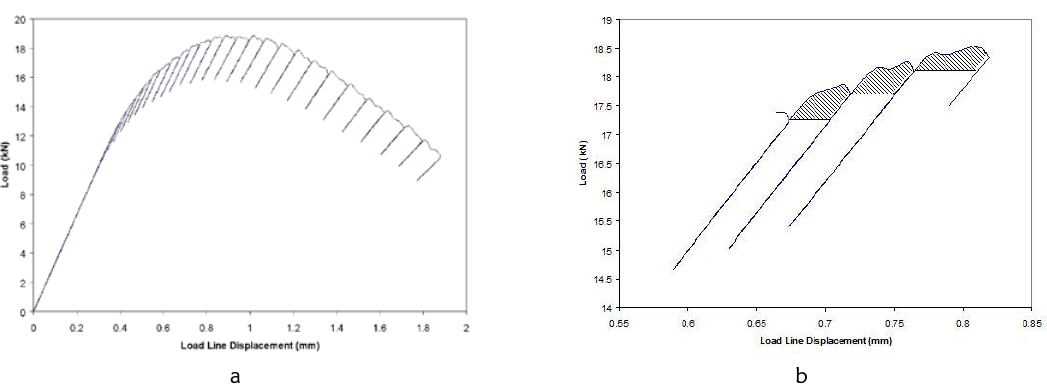
Figure 3: (a) Load versus LLD Plot and (b) Areas Representing